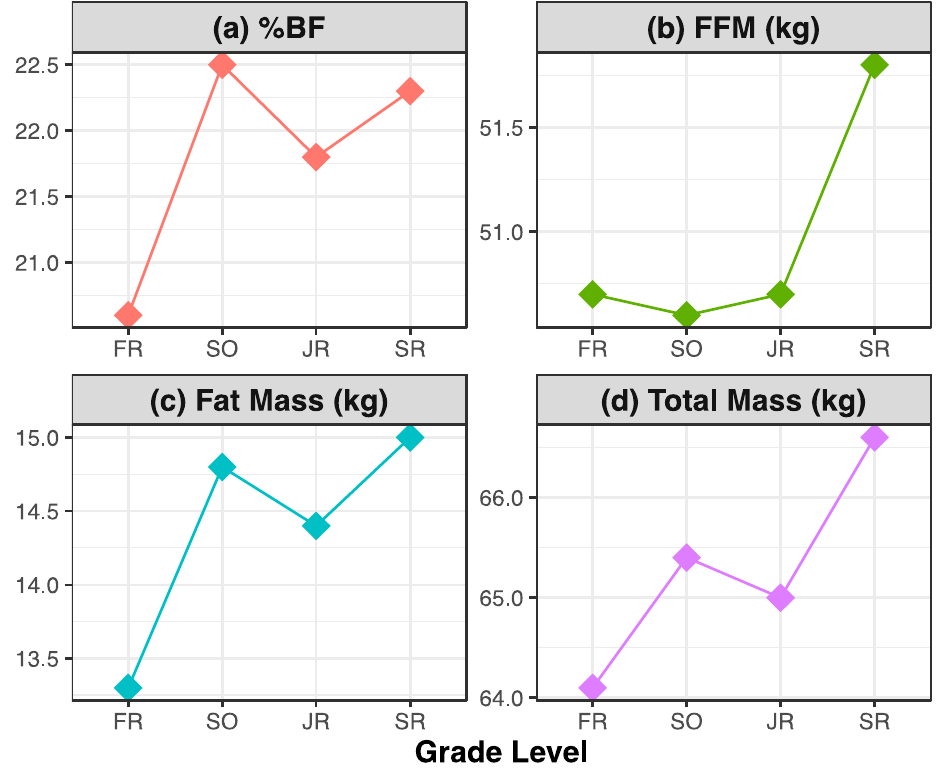
Figure 1. Average adjusted body composition measures by grade level, averaged over time point (pre- and post-season). ( a ) average percent body fat by grade level; ( b ) average fat-free mass by grade level, in kg; ( c ) average fat mass by grade level, in kg; ( d ) average total mass by grade level, in kg.